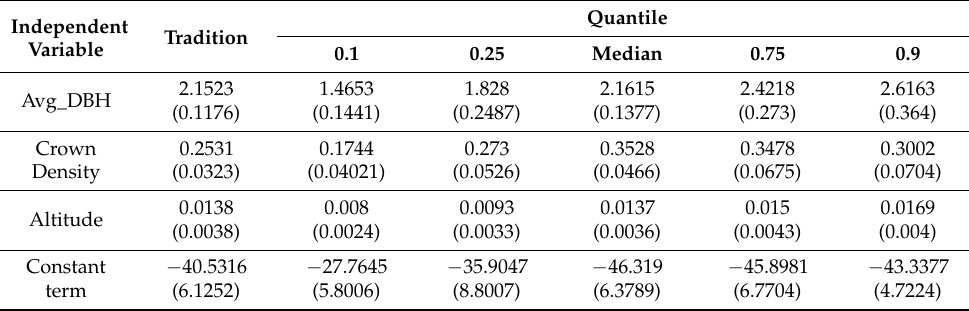
Table 7. Regression result.